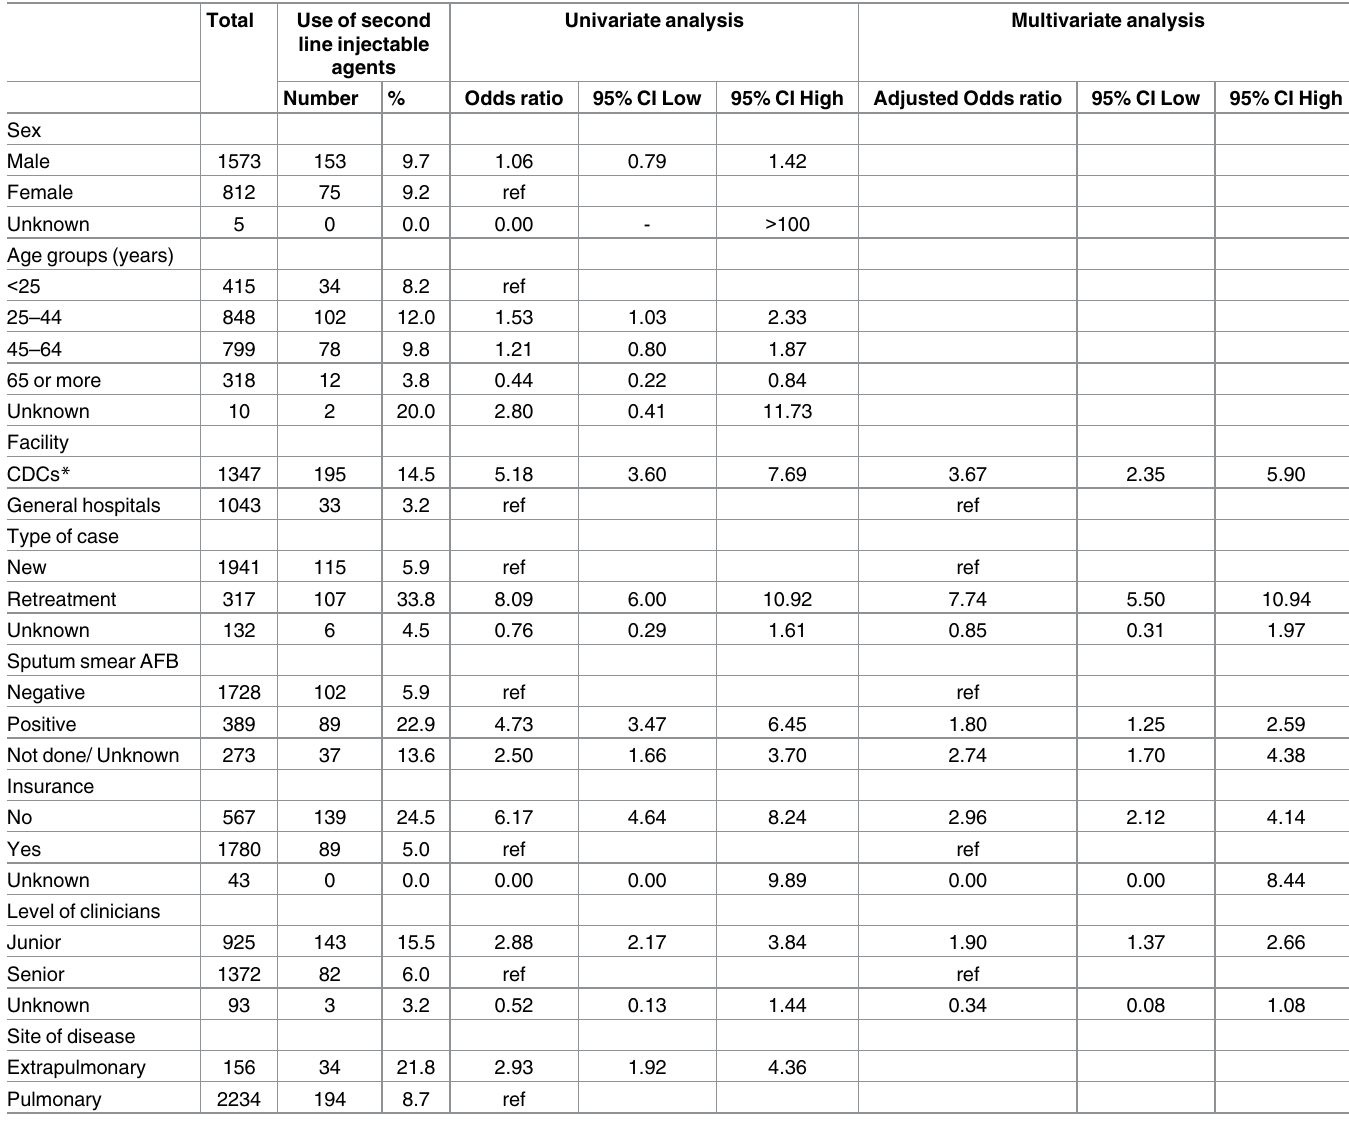
Table 4. Factors associated with the use of second line injectable agents in the treatment of new and retreatment tuberculosis cases,